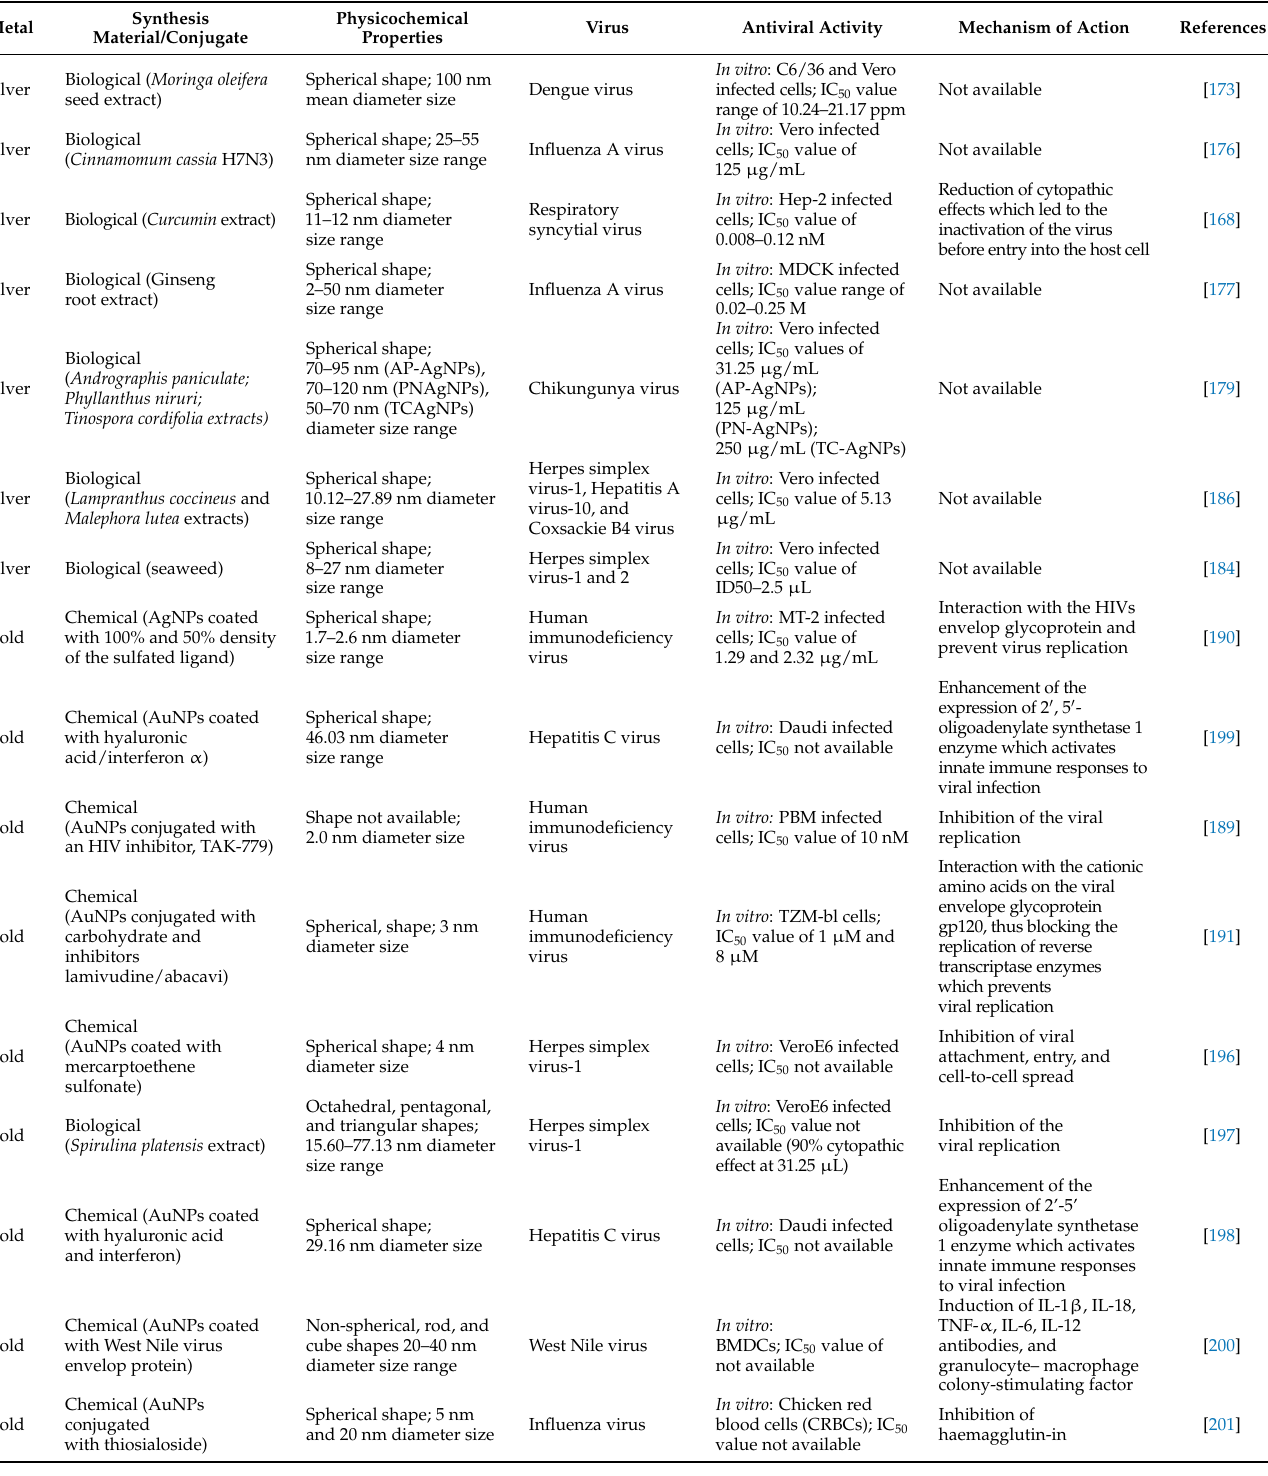
Table 5. Antiviral activity of metal NPs against various viruses and possible